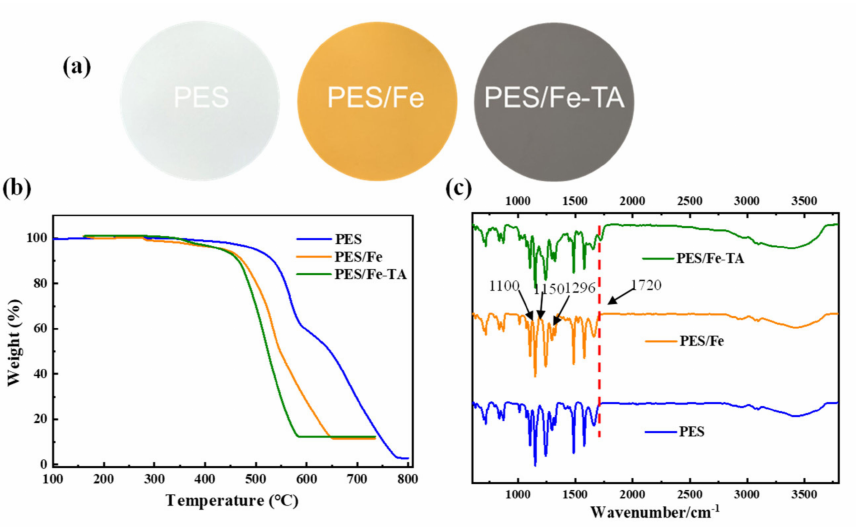
Figure 3. ( a ) Digital photographs of membrane surface, ( b ) TGA curves and ( c ) ATR-FTIR spectra of the PES, PES/Fe and PES/Fe-TA